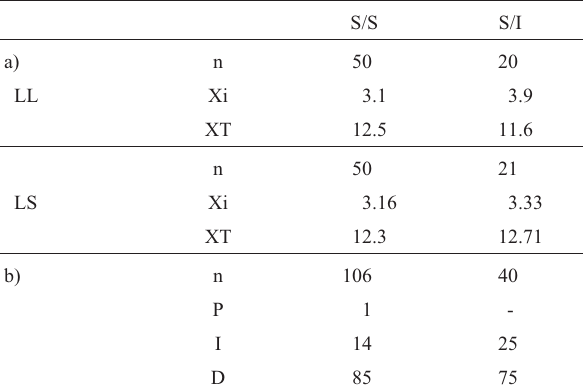
Table3 -a)Interstitial(Xi)andtotal(XT)chiasmafrequenciesinstandard homozygotes (S/S) and heterozygotes for the M7 inversion (S/I) of the 1988 “Los Loros”(LL) and “Los Sauces” (LS) populations (n: number of analyzed cells). b) Chiasma distribution (percentage) in the M7 bivalent (P: proximal, I: interstitial, D: distal).